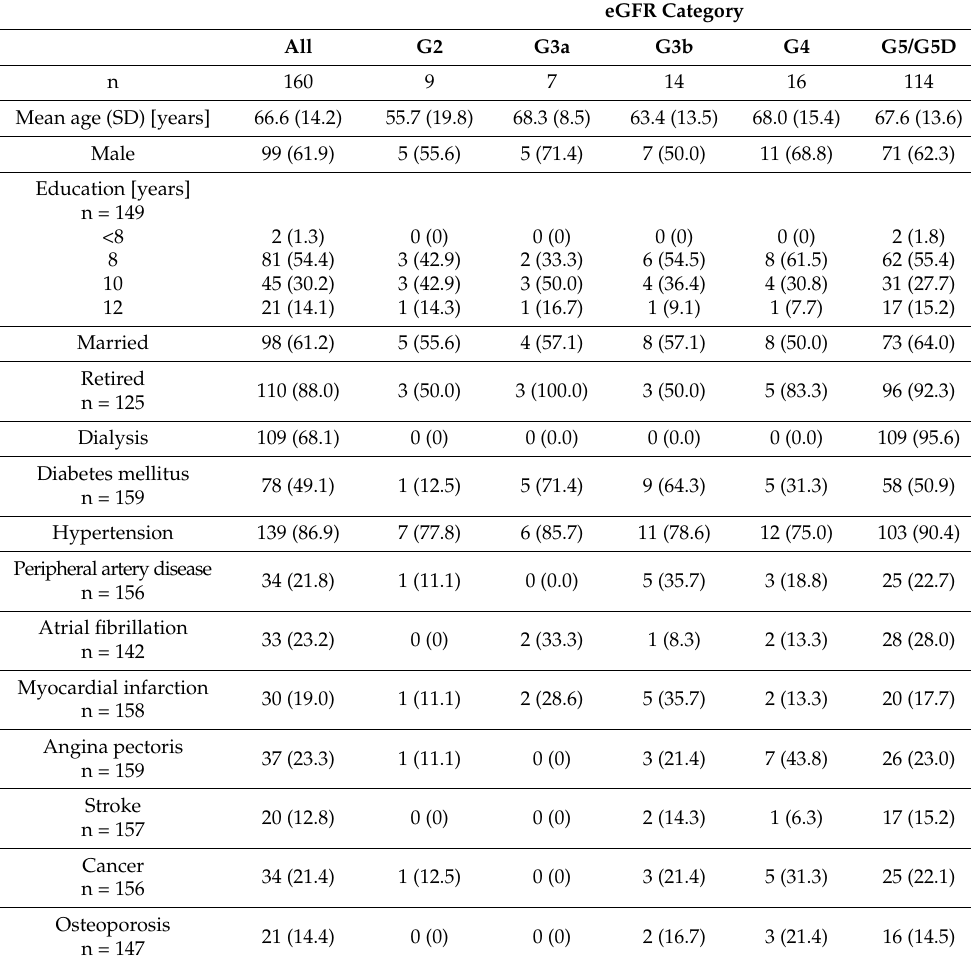
Table 1. Sociodemographic data and comorbid